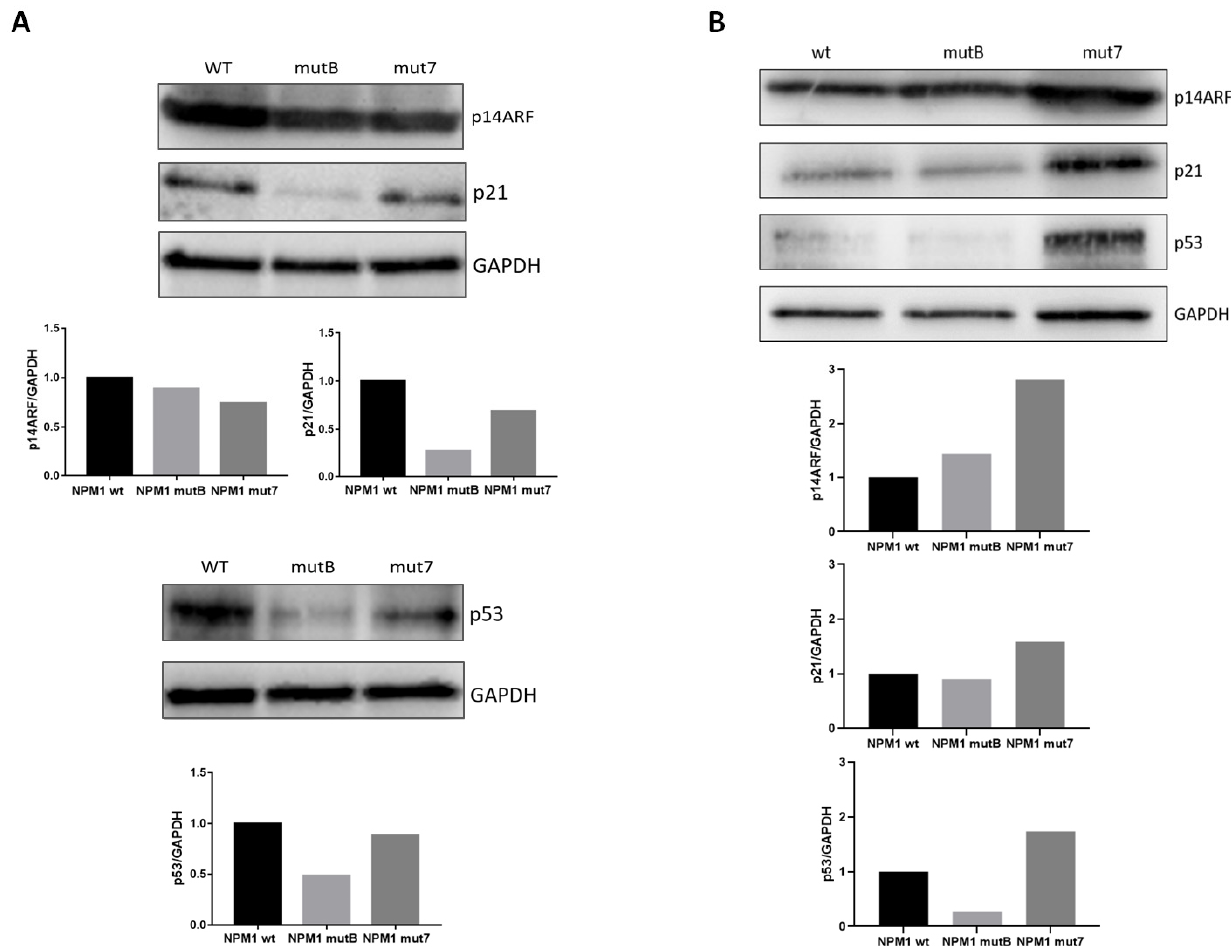
Figure 3. Impact of different NPM1 mutations on p53 pathway. ( A , B ) Western blot showing p14ARF, p21, and p53 protein levels in HL-60 ( A ) and SHI-1 cells ( B ) transfected with pEGFP-NPM1wt, pEGFP-NPM1mutB (A-like), and pEGFP- NPM1mut7 (non-A-like) plasmids. GAPDH was used as calibrator. Histograms show protein quantification using ImageJ software, and normalized with respect to GAPDH